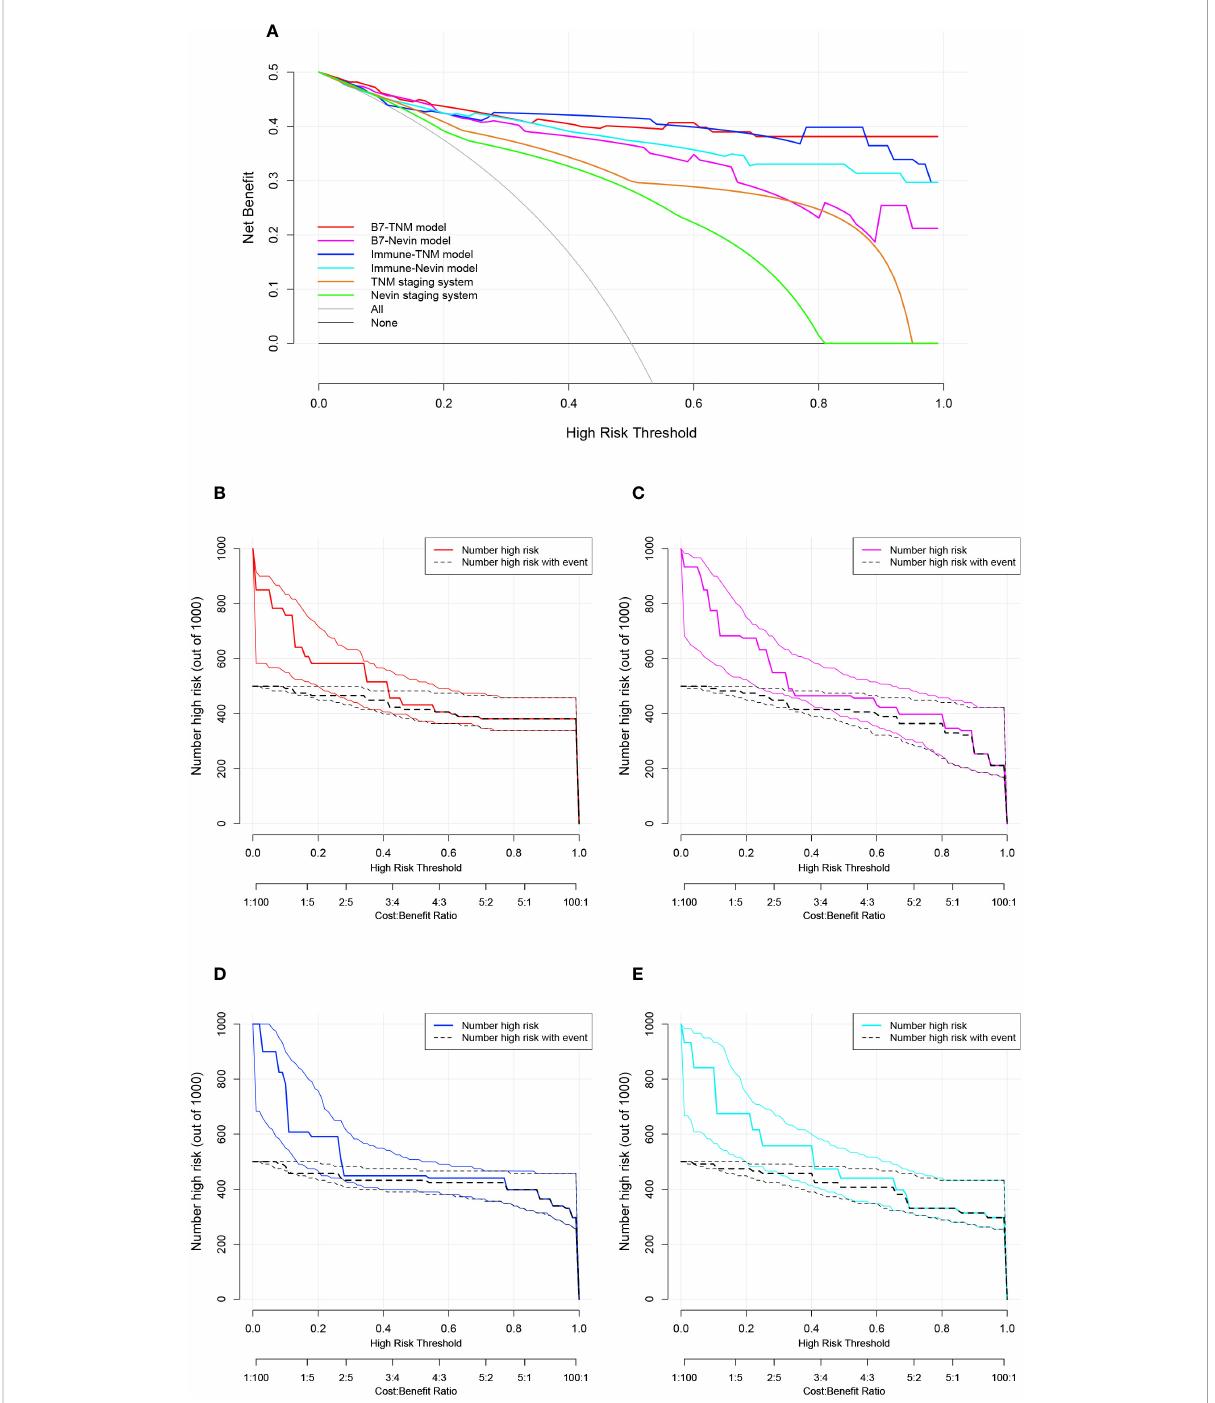
FIGURE 6 Decision curve analysis (DCA) and clinical impact plots to investigate the potential clinical effects of the novel models. (A) The clinical effects were assessed by quantifying the net bene fi ts at different threshold probabilities. A higher net bene fi t indicated better estimation for decision- making; (B – E) Clinical impact curves for the B7-TNM model, B7-Nevin model, Immune-TNM model, and Immune-Nevin model. The two horizontal axes present cost: bene fi t and corresponding risk threshold. The heavy solid line in different colors for each prediction model shows the estimated high-risk number of 1000 patients, while the black dashed line shows the number of true-positive cases. All plots ’ light solid and dashed lines represent the 95% CI constructed by